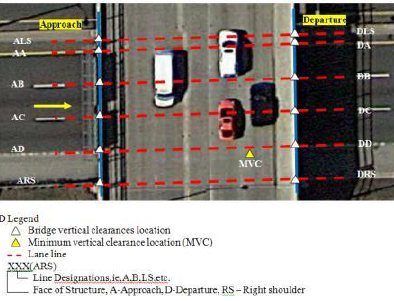
Figure 7. Vertical clearances in the plan view